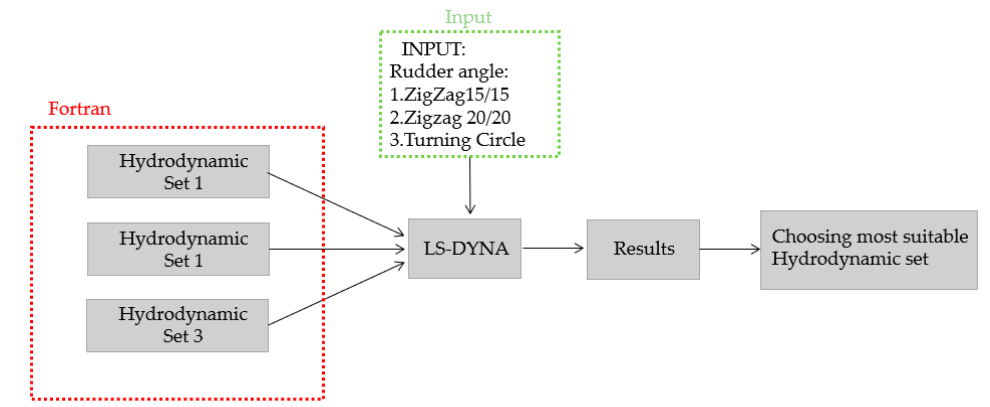
Figure 4. Procedure of results validation.